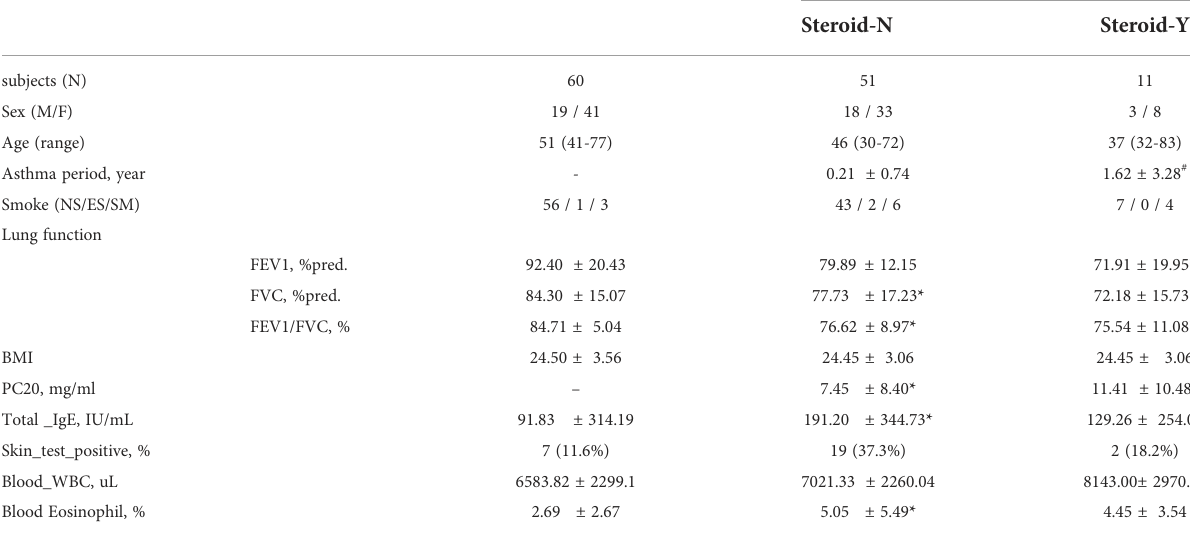
Data expressed as mean ± SD or median (range); SM; smoker, ES; ex-smoker, NS; non-smoker, FEV1; forced expiratory volume in one second. FVC; forced vital capacity. PC20; the concentration of methacholine required to decrease the FEV1 by 20%, BMI; body mass index. Steroid N; steroid no treatment, Steroid Y: steroid treatment for exacerbation. *p< 0.05 compared with control subjects. # p<0.05 compared with Steriod-N